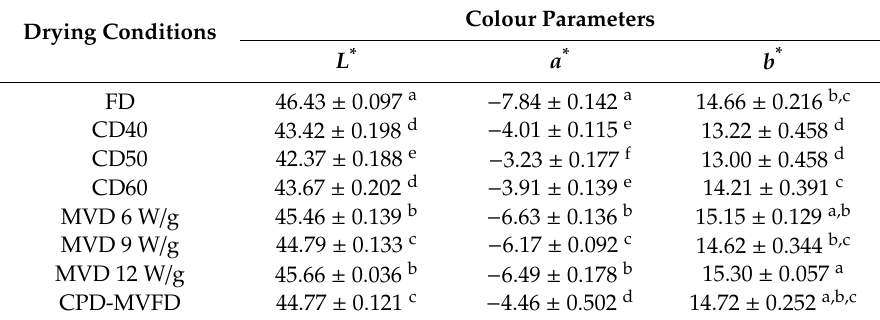
Table 4. Colour parameters of M. koenigii leaves after the drying treatment. Colour Parameters Drying Conditions L * a * b